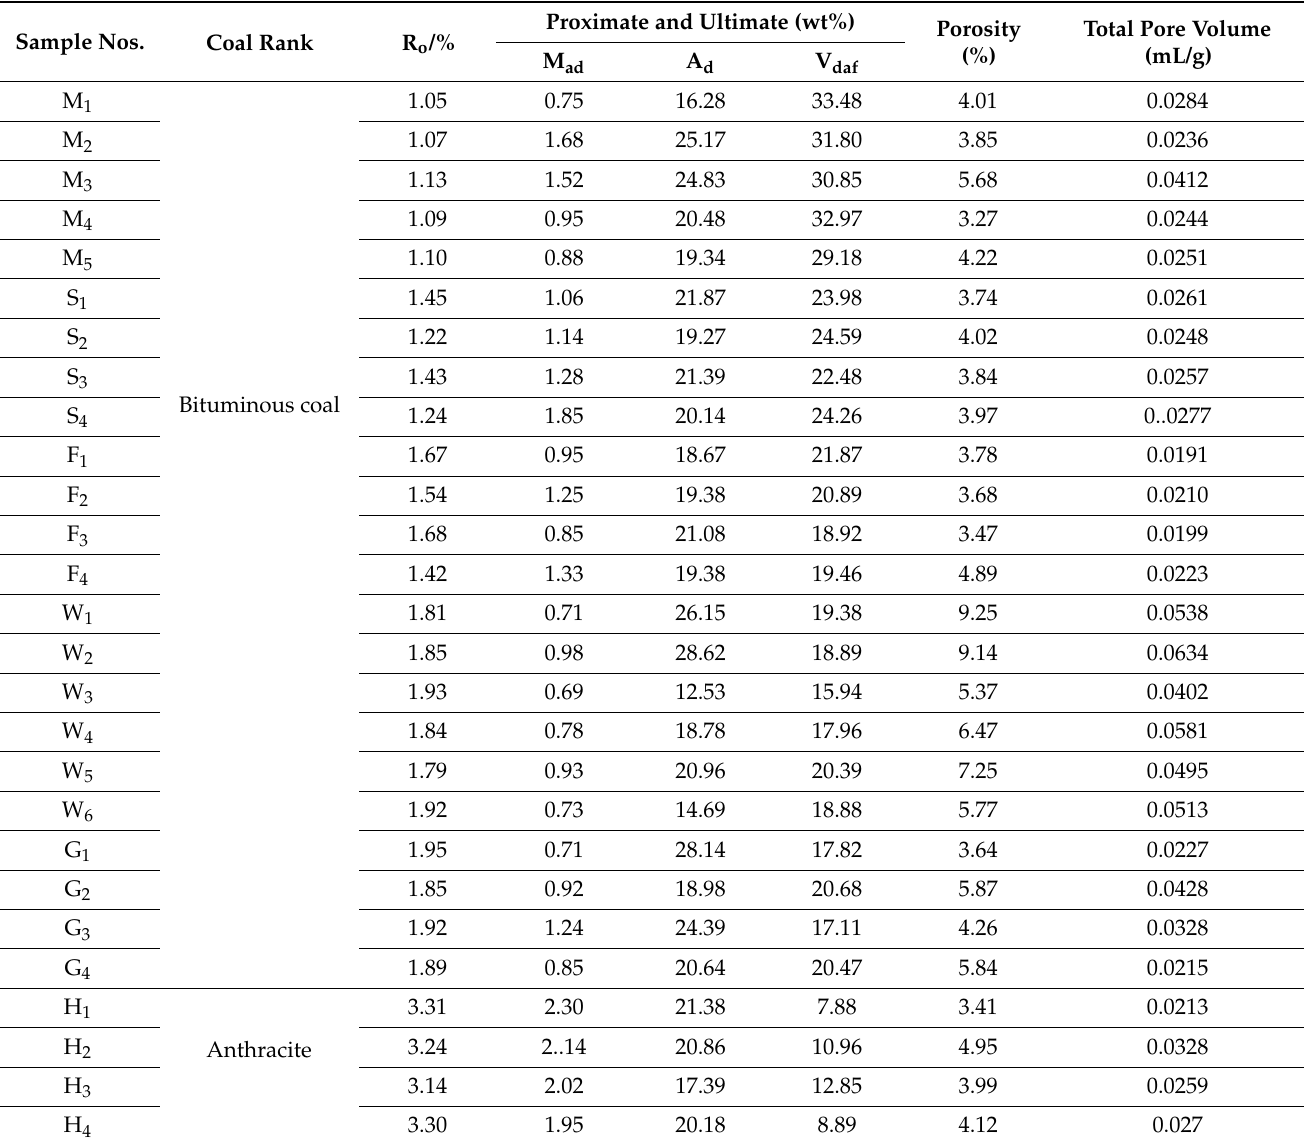
Table 1. Test results of coal